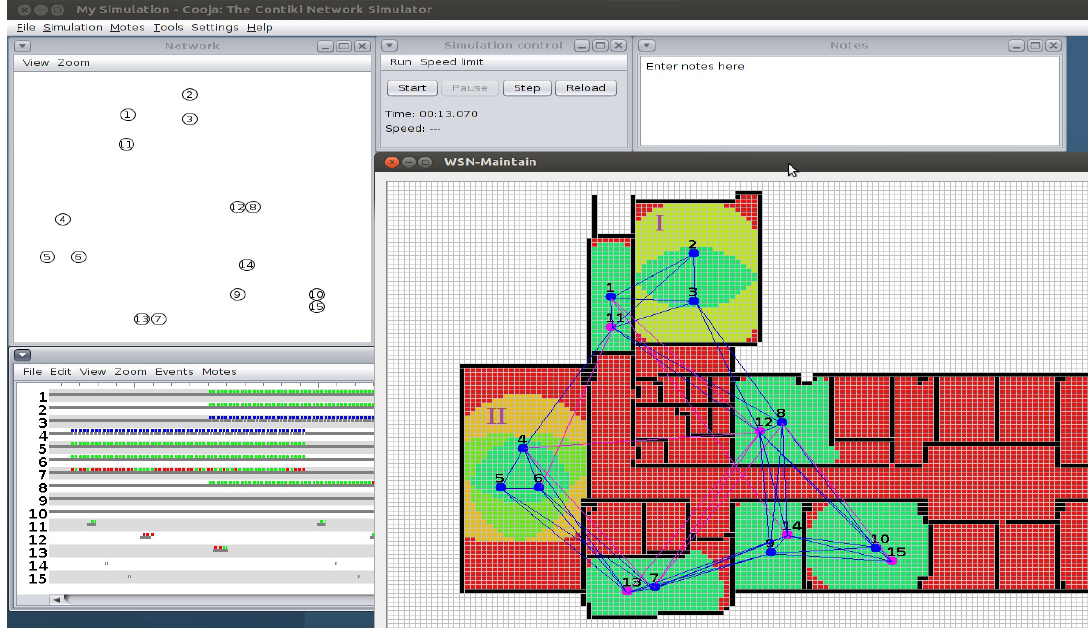
Figure 3. WSN-Maintain runs in parallel with